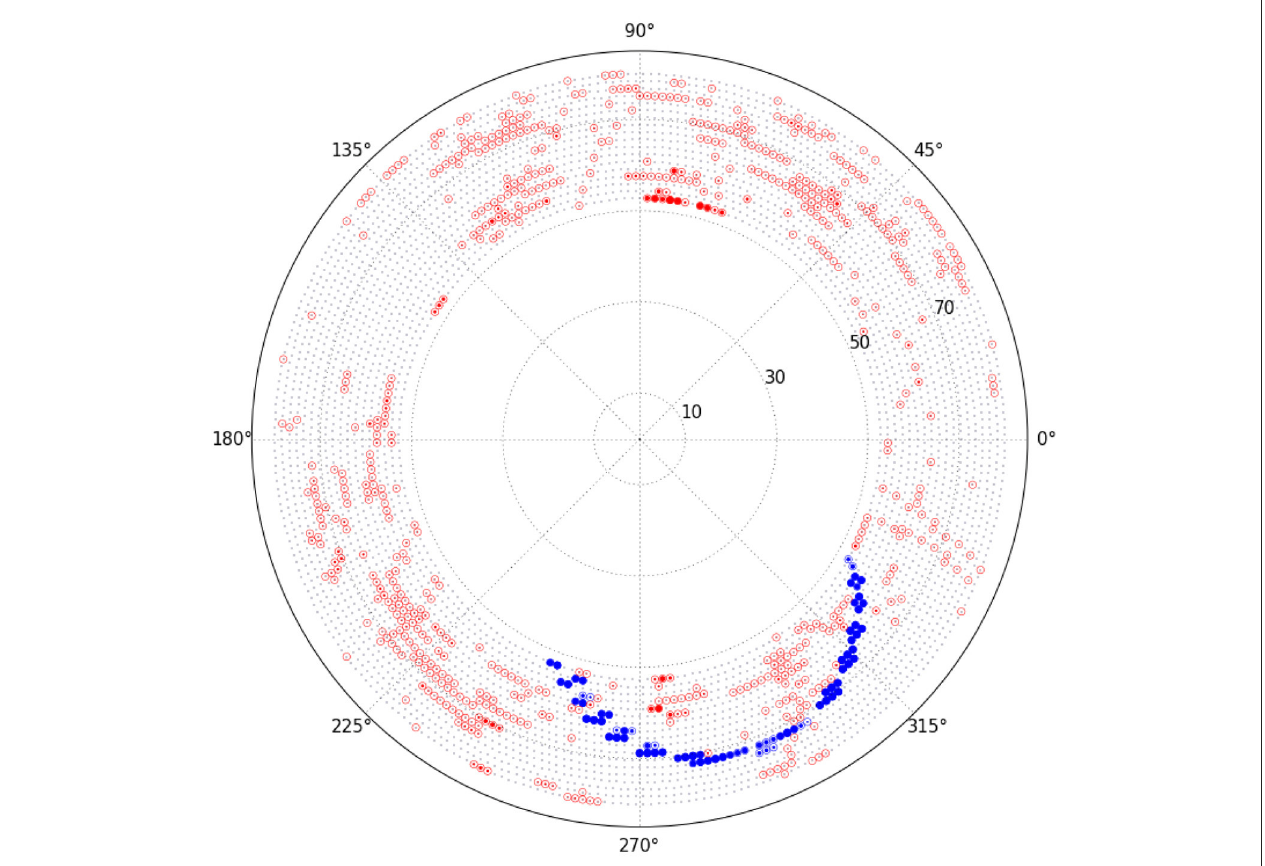
FIGURE 6 | A visual representation of the hit level GBDT applied to the signal event with background hits. The red and blue filled circles are passed hits by GBDT application, while empty circles are rejected. Big blue arc pattern is a signal electron.